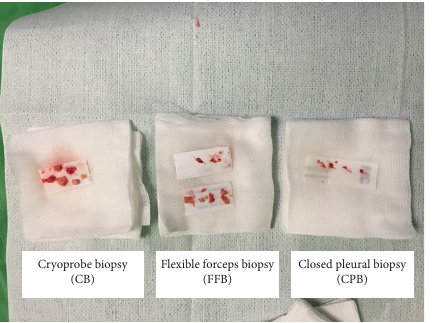
Figure 2: The pleural biopsy obtained by CB had larger tissue size with better tissue integrity compared to the other two methods.